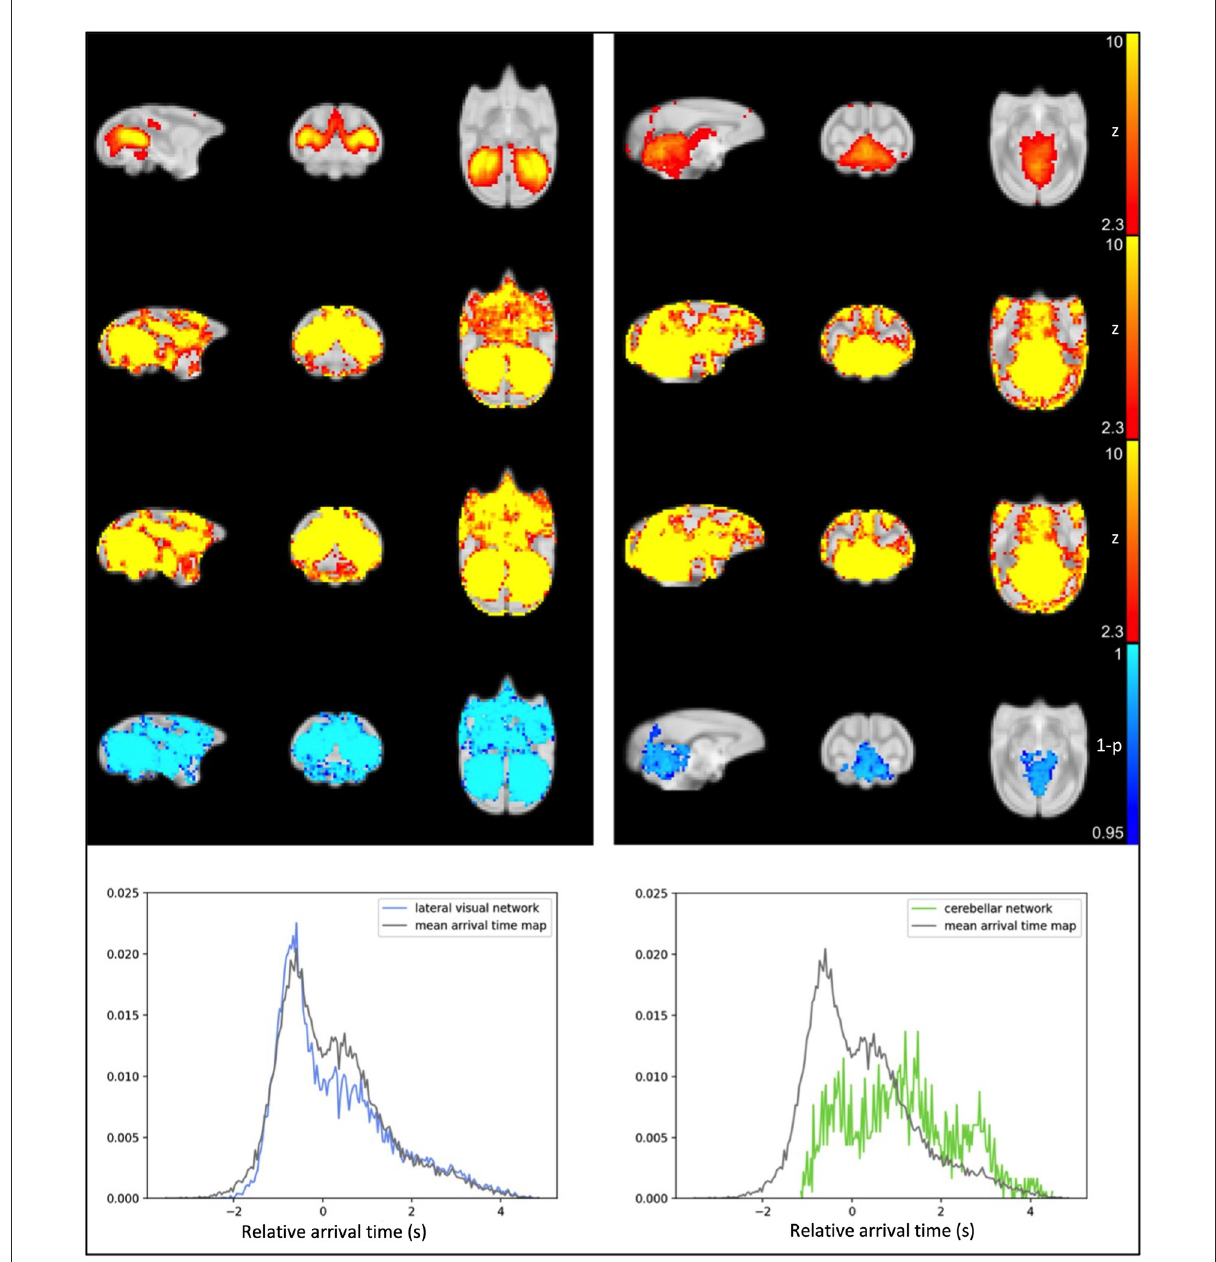
FIGURE3 Results from IC1, the lateral visual (left) and IC14, the cerebellar network (right) . Top row: IC computed from original data; second row: averaged spatial ICs of non-denoised dataset; third row: averaged spatial ICs of denoised dataset; fourth row: statistical map representing significant reduction in IC after sLFO removal (TFCE-corrected), the number of significant voxels is also calculated and indicated above the statistical map; fifth row: probability density map showing number of voxels within IC at different sLFO arrival